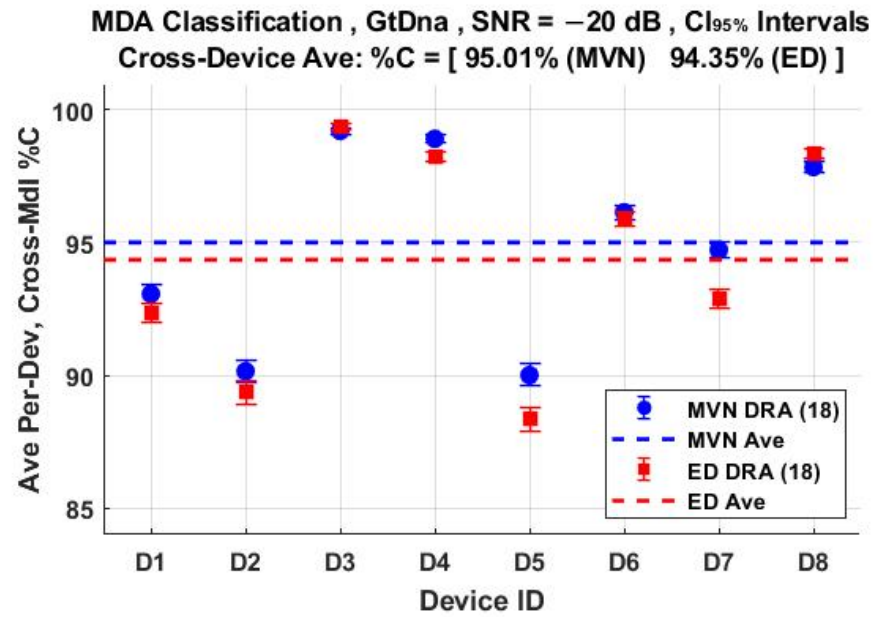
Figure 13. Per-device MDA classification performance for the N Mdl = 56 models in Table 2. Results are for jointly selected N DRA-GT = 18 features generated under SNR = − 20 dB conditions using ED ( ■ ) and MVN ( ● ) measures of similarity.